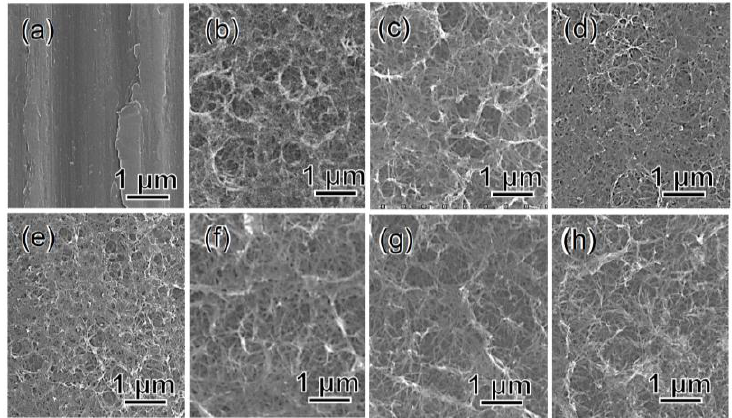
Figure 1. FE-SEM photographs of surfaces of Ti ( a ) untreated or subjected to ( b ) NaOH treatment, and subsequent ( c ) 100Ca + 0.05Ga and ( d ) heat treatment, and finally ( e ) water treatment, or ( f ) 100Ga after the NaOH treatment, and subsequent ( g ) heat and finally ( h ) water treatment.